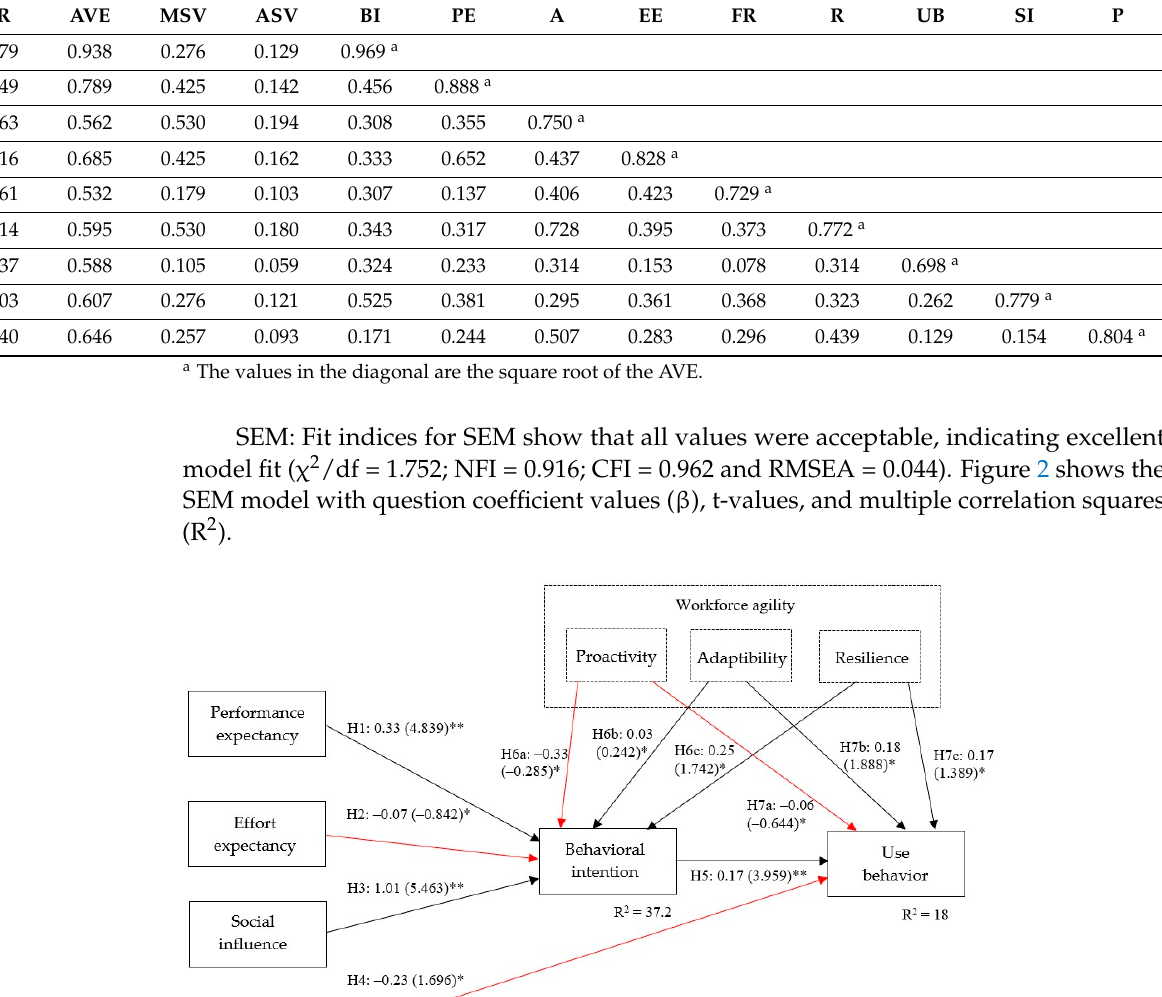
Table 4. UNS—Discriminant and convergent validity of the measuring instrument.